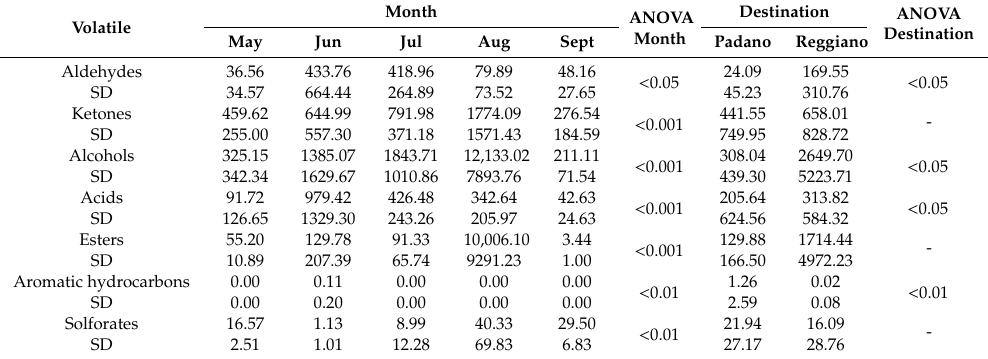
Volatiles concentrations (mean ± standard deviation, ng / gEq) for the seven classes of chemicals, subdivided for month and milk destination. The table reports the p -values for ANOVA. SD: standard